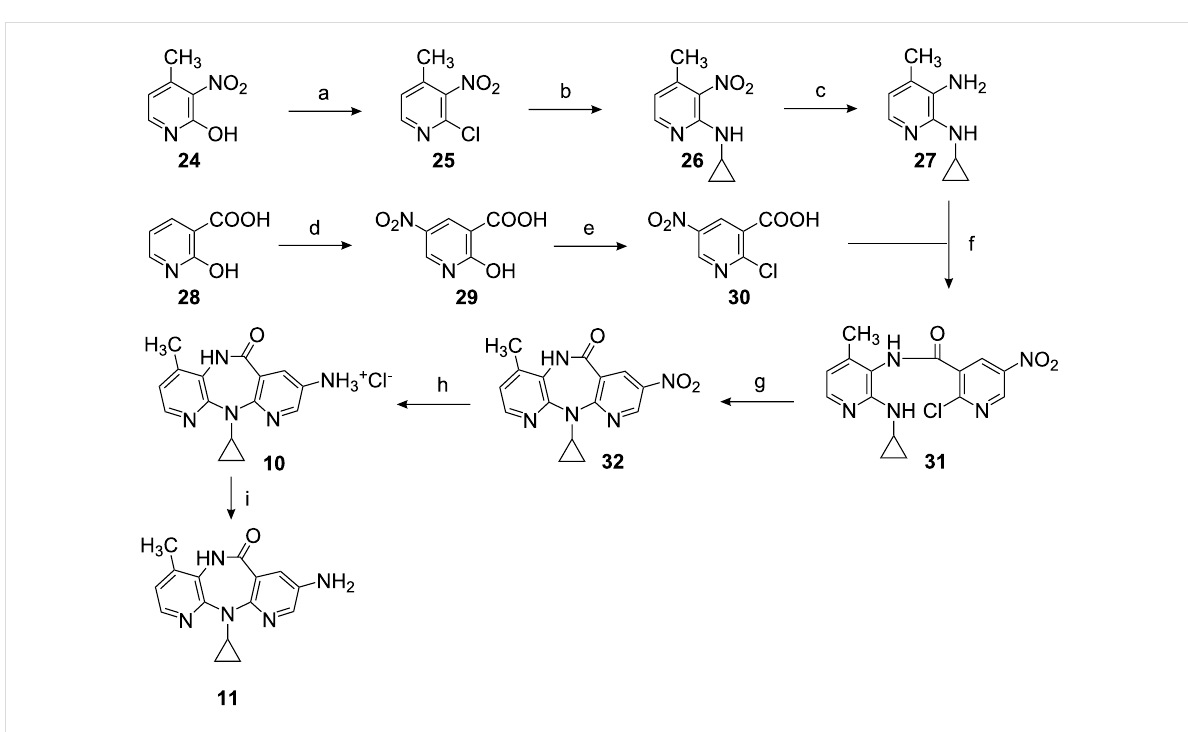
Scheme 3: Reagents and conditions: (a) POCl 3 , 150 °C, 6 h, 85%; (b) cyclopropylamine, xylene, 105 °C, 4 h, 99%; (c) SnCl 2 ·2H 2 O, conc. HCl, CH 3 COOH, rt, 3 h, 83%; (d) 69% HNO 3 , conc. H 2 SO 4 , 50 °C, 7 h, 79%; (e) POCl 3 , reflux, 4 h, 78%; (f) i) 30 , (COCl) 2 , benzene, DMF, rt, 1 h; ii) 27 , THF, DIPEA, rt, 5 h, 53%; (g) HMDS, 110 °C, 24 h, 90%; (h) SnCl 2 ·2H 2 O, conc. HCl, CH 3 COOH, rt, 3h, 73%; (i) 50% aq. NaOH, rt, 1 h,